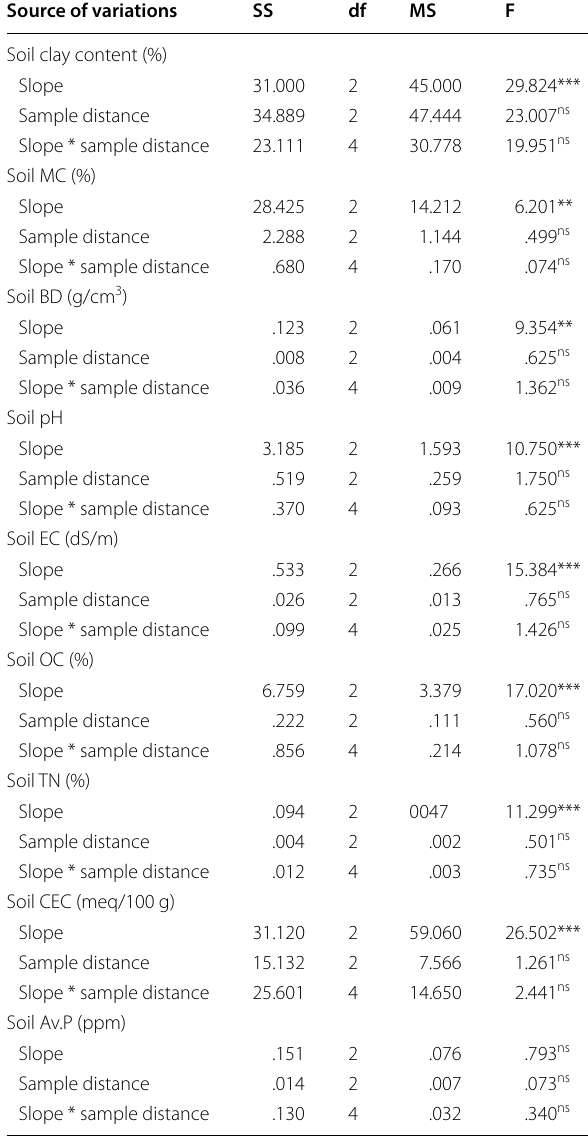
Table 4 Main and interaction effects of slope and soil sample distance from bund on basic soil